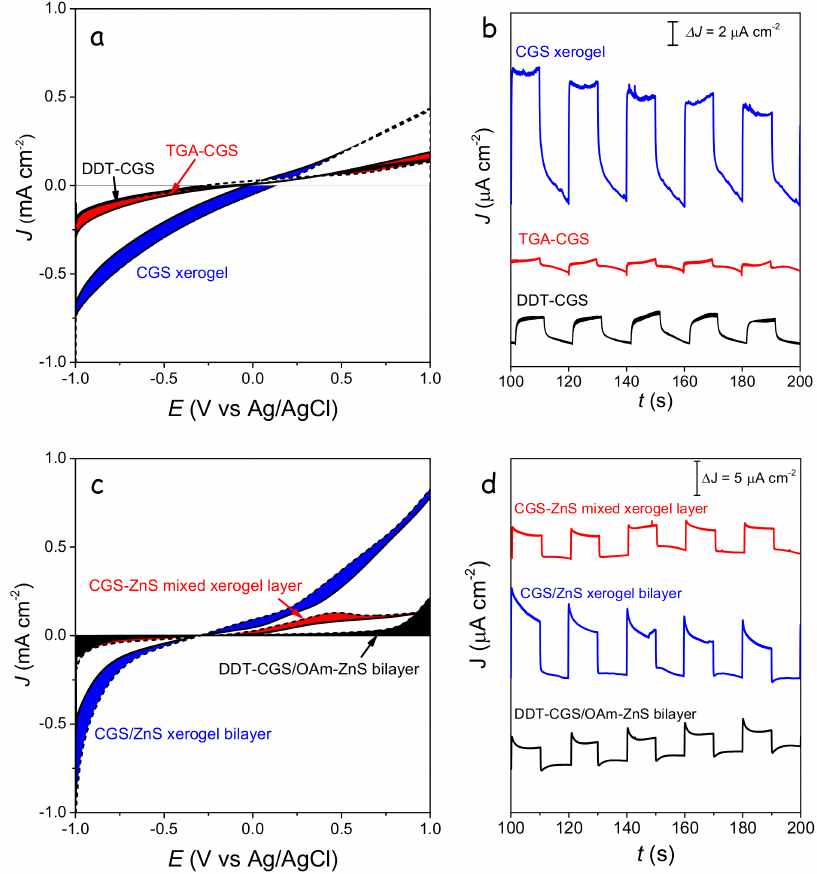
Figure 10. ( a , b ) linear sweep voltammogram curves at a scan rate of 0.1 V · s − 1 ( a ) and time-dependent characteristics ( b ) of the photocurrent response of CGS layers having different surface chemistries. ( c , d ) linear sweep voltammogram curves at a scan rate of 0.1 V · s − 1 ( c ) and time-dependent characteristics ( d ) of the photocurrent response of CGS/ZnS bilayers and a CGS-ZnS mixed layer. Time-dependent characteristics were obtained by applying − 0.6 V with respect to an Ag/AgCl reference